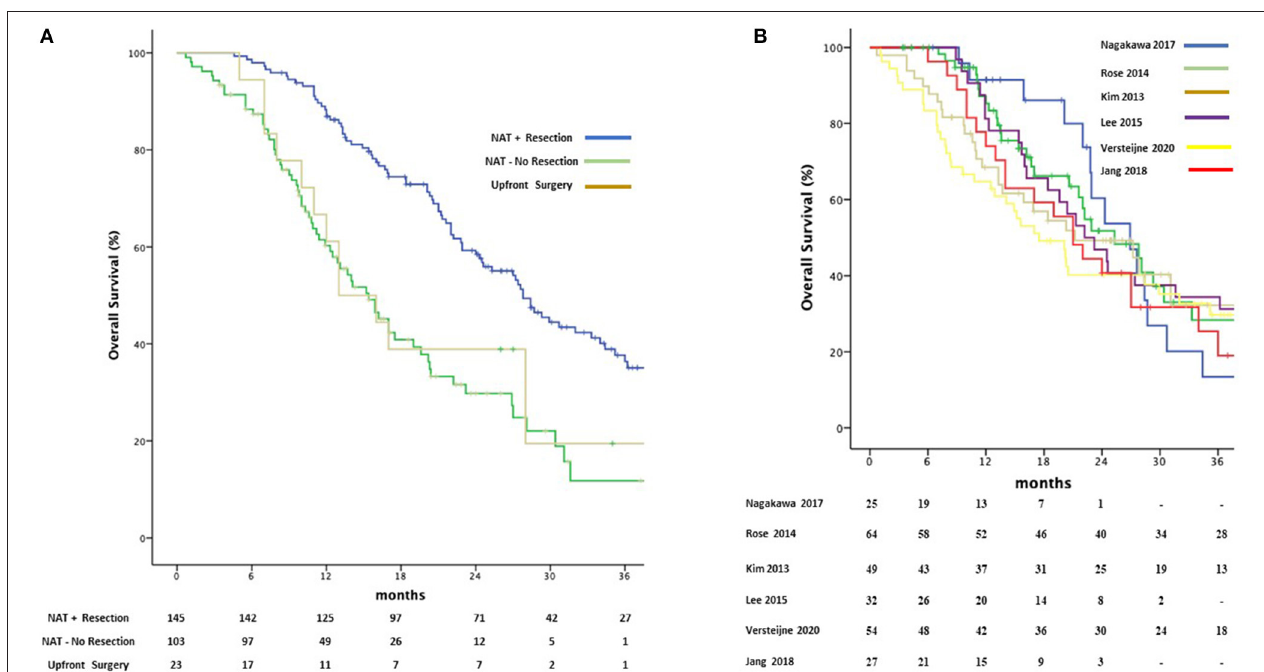
FIGURE 4 | Kaplan-Meier curves for pooled overall survival in patients receiving NAT-GEM following by resection and patients who received GEM-NAT but did not undergo resection or underwent upfront surgery (A) and amongst Treatment Protocols (B)